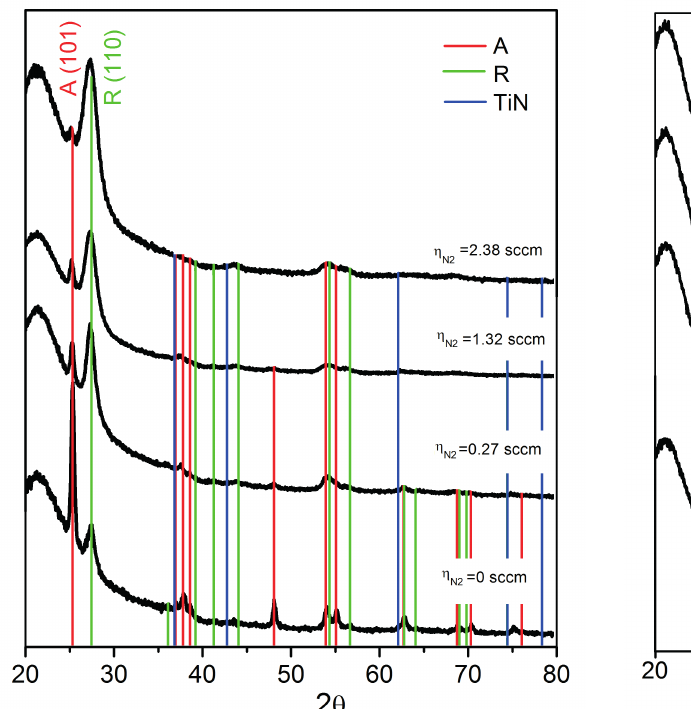
:N thin films deposited 2-x =0.3 under controlled nitrogen 0